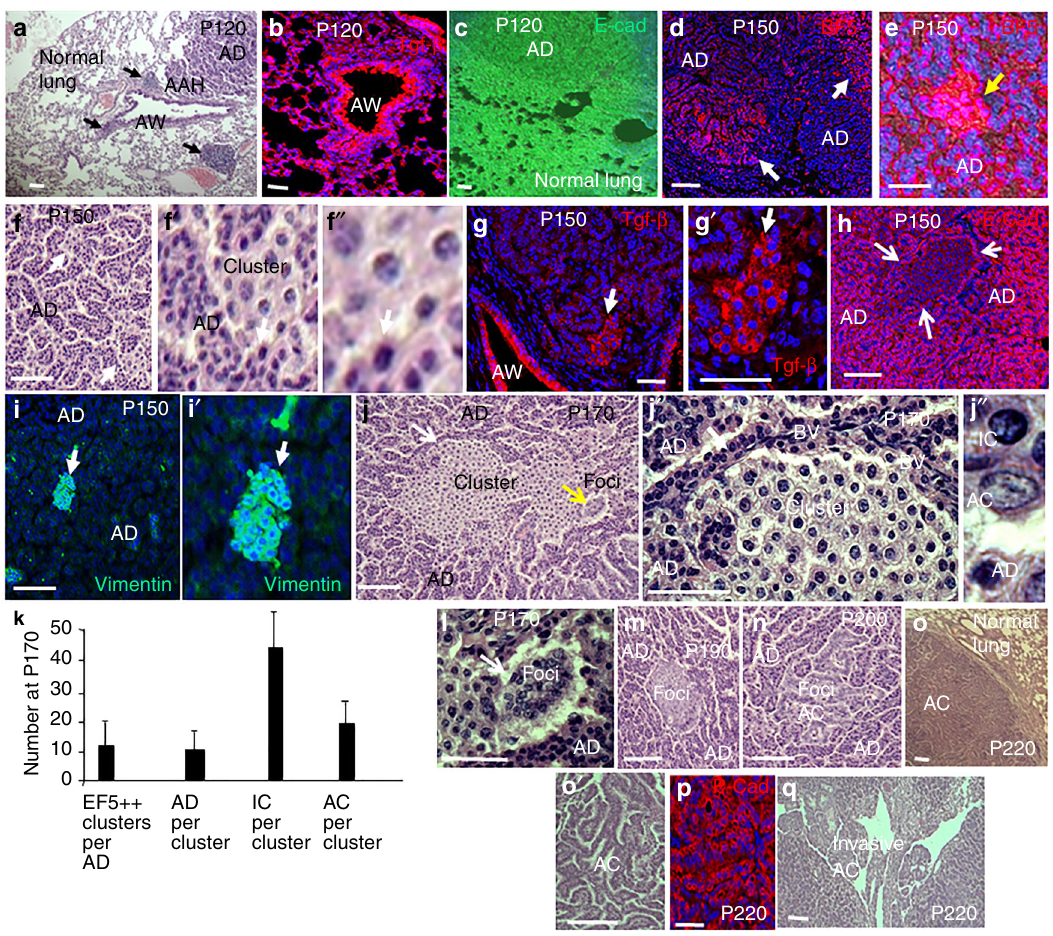
Fig. 1 In fl ammation, Tgf- β 1 accumulation, hypoxia, and EMT mark cancer cell-generating clusters in expanding adenomas. a H&E staining showing sites of atypical adenomatous hyperplasia (AAH) originate around bronchial airways (AW), and then begin expanding into precancerous adenomas (AD) by P120 in K-Ras mutant mice. These sites are linked to in fi ltrating in fl ammatory cells. High concentrations of in fl ammatory cells are shown by black arrows, but lower levels of these in fi ltrating cells have spread throughout the lung. b Sites of AAH, AD, and in fl ammation are rich in Tgf- β 1. c Normal lung, AAH. and AD express E-cadherin (E-cad). d Immunostaining for EF5 shows that by P150 the interiors of expanding AD are hypoxic (EF5 + ). e Highly EF5-positive sites (EF5 ++ ) are present in the hypoxic interiors of expanding AD. f – f ″ EF5 ++ sites represent small clusters of cells with decondensed chromatin. Arrows in panel f show two such clusters surrounded by AD cells, which contain small nuclei with dense heterochromatin. Arrows in panels f ′ and f ″ show the same location. g , g ′ EF5 ++ clusters are sites of Tgf- β accumulation. Arrows show the same position in panels g and g ′ . h Consistent with EMT, loss of E-cad marks cell clusters. Arrows show the outline of the cluster. i , i ′ The mesenchymal marker Vimentin is induced in cell clusters. Arrows show the same position in panels i and i ′ . j – j ″ By P170, clusters have expanded. The yellow arrow in panel j shows cancer cells forming dense foci (see panel k ). The white arrows in panels j and j ′ show the same position. “ BV ” are blood vessels within AD at the AD/cluster border. Note absence of BV within the cluster. Panel j ″ shows an AD cell with a small heterochromatin dense nucleus, a euchromatic AC cell containing a larger euchromatic vesicular nucleus with an irregular contour and nucleolar enlargement, and a cell with an intermediate nuclear morphology evidenced by heterochromatin decondensation. These cells displaying an intermediate nuclear morphology are termed intermediate cells (IC). k Hypoxic EF5 ++ clusters, fi rst identi fi ed in panel e , were counted per adenoma, and cell types were counted within clusters at P170 in four lungs (20 adenomas). l – n AC cells assemble into dense foci and form papillary structures. The yellow arrow in panel l shows the same position in panel j . o , o ′ By P220, AC cells had formed large tumors. p As opposed to IC, but similar to adenoma cells, the tumors cells expressed E-cad and thus did not show evidence of EMT. q Invasion of expanding tumors into airways is shown. n > 5 for each age. Bars are 50 μ